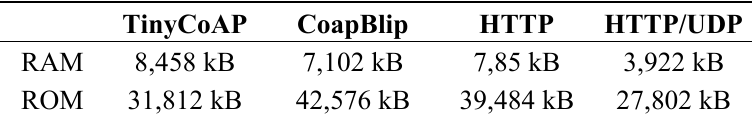
Table 3. RAM and ROM memory occupation. TinyCoAP reserves all the memory required at compile